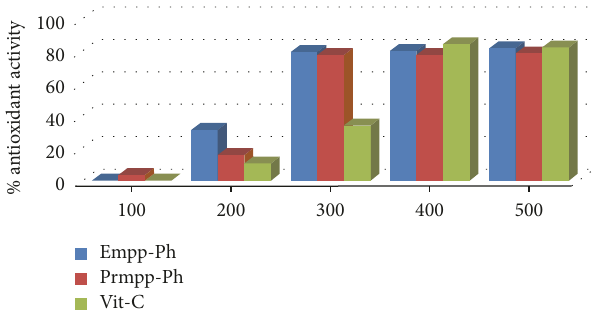
Figure7:Chartshowingtheantioxidantactivitiesofacylpyrazolone